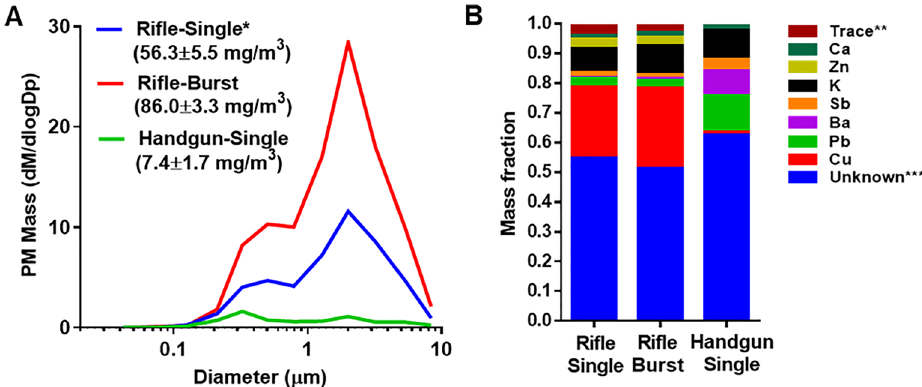
Figure 1. Physico-chemical properties of the rifle and handgun smoke PM. ( A ) PM mass and sizes, ( B ) Inorganic element mass fractions. *Data were collected from the muzzle of the M4 rifle. **Sum of the rest of quantified elements. ***Expected sum of unquantified elements such as N, O, C, and